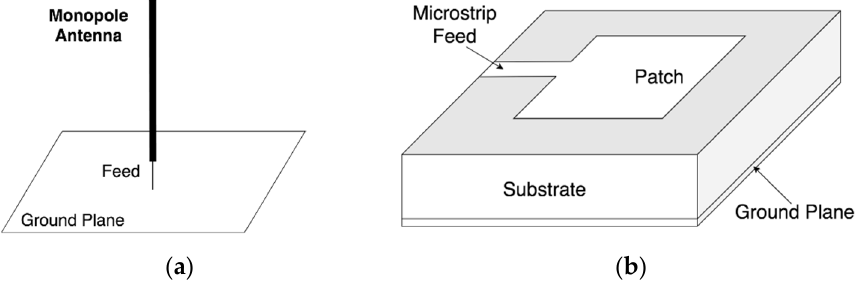
Figure 4. Typical antenna structure: ( a ) monopole antenna; ( b ) microstrip antenna.